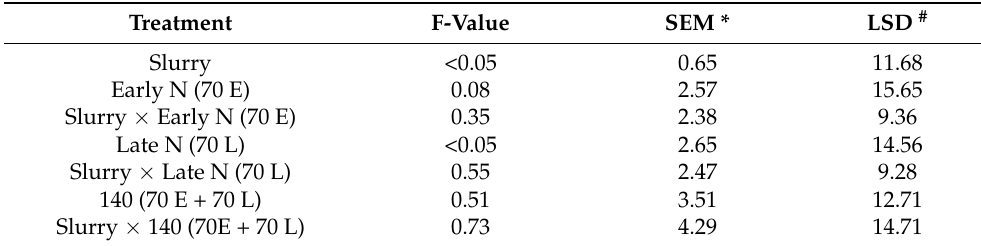
Table 11. 2017/18 F-values for total N offtake at 0% DM (kg/ha).